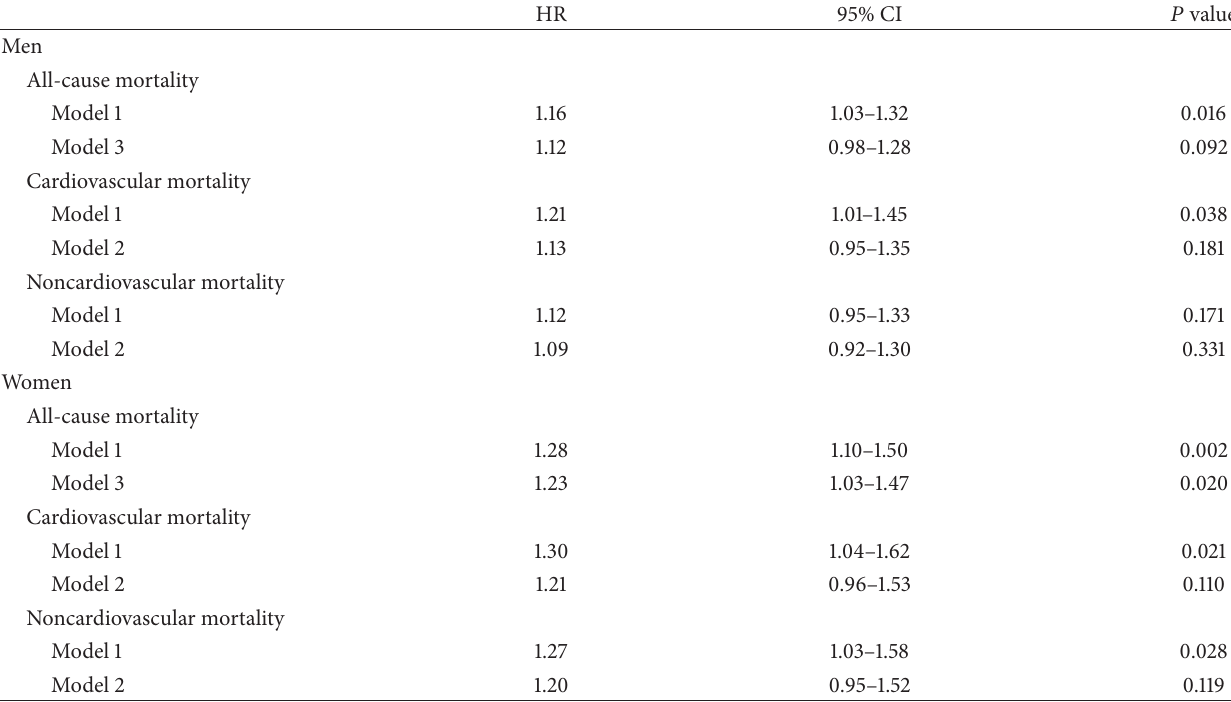
Table 2: Cox regression analyses of all-cause, cardiovascular, and noncardiovascular mortality according to WBC count stratified by sex ( 𝑛 = 207 men and 𝑛 = 220 women).